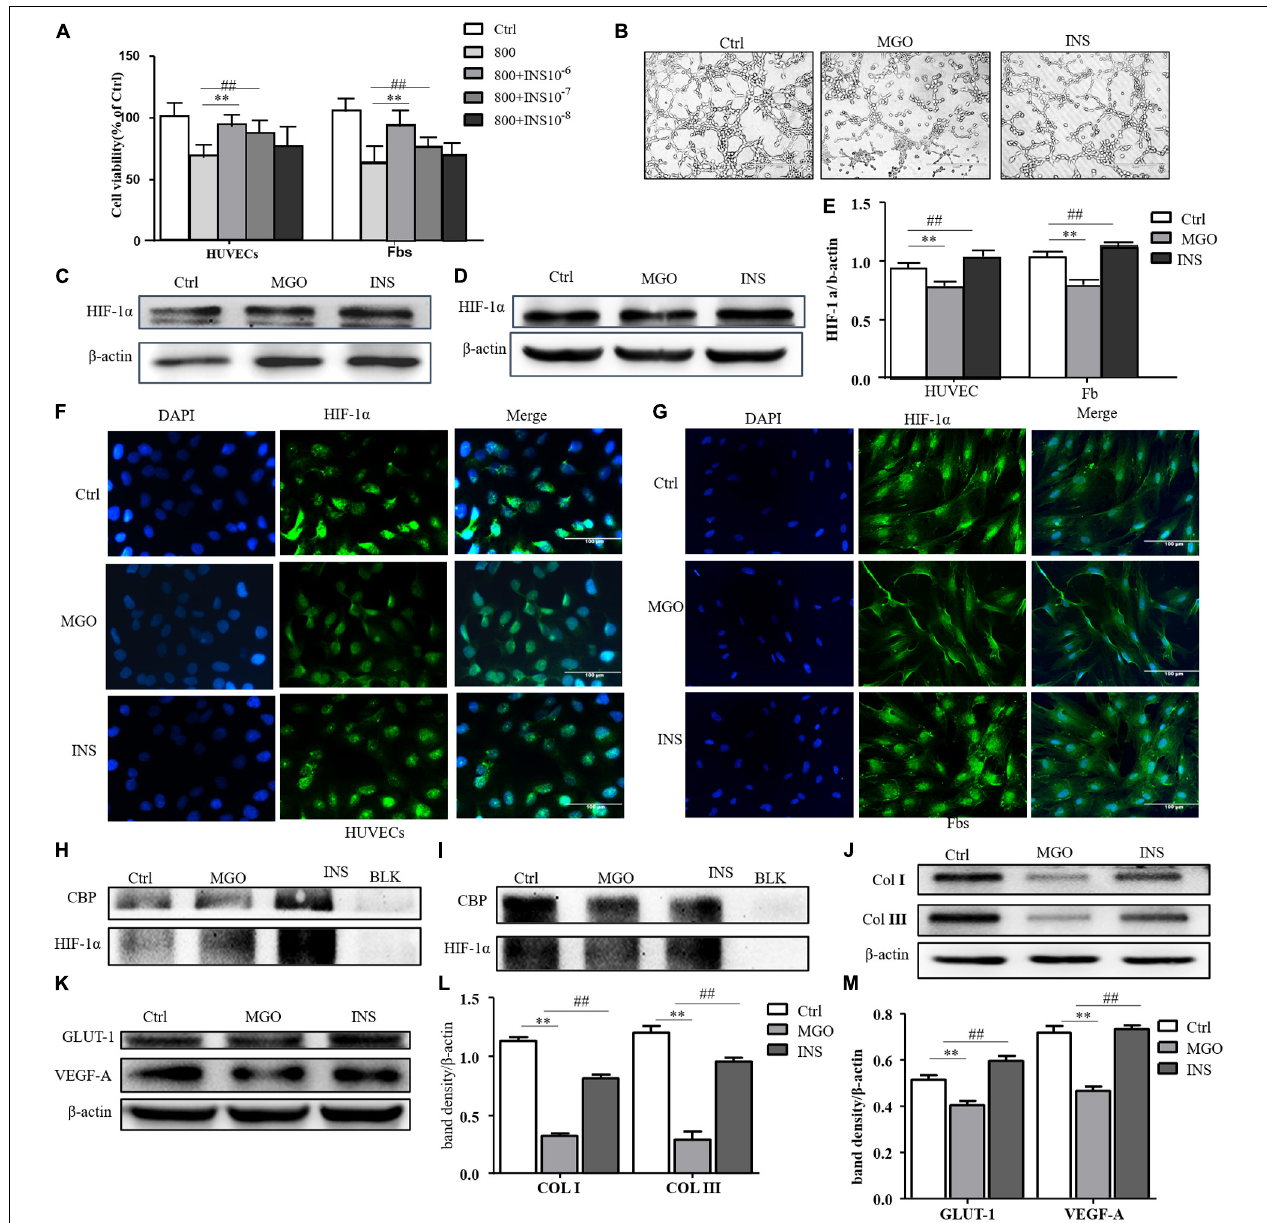
FIGURE 4 | Insulin relieved MGO-induced HIF-1 α impairment in wound healing cells. (A) Insulin promoted MGO-induced cell viability impairment in a concentration-dependent manner. HUVECs and fibroblasts were pretreated with 0 (control group) and 800 µ M MGO for 30 min. Thirty minutes after MGO treatment, 0, 10 - 6 , 10 - 7 , and 10 - 8 M insulin were added to the culture medium. After 24 h of incubation, cells were subjected to CCK-8 analysis. The viability of each group was compared with that of the control group and presented as the percentage of the control group. Data are shown as mean ± SD. **/## p < 0.01, n = 3. (B) Insulin promoted MGO-induced HUVEC angiogenesis impairment. HUVECs were set into three groups: control group (Ctrl) treated without MGO and insulin; MGO group (MGO) treated with 800 µ M MGO; insulin group (INS) treated with 800 µ M MGO and 10 - 6 M insulin. The treatment was described previously. Twelve hours later, the tube formation status in both groups was photographed. (C–E) Insulin alleviated MGO-induced HIF-1 α accumulation impairment of HUVECs and fibroblasts. HUVECs and fibroblasts were set as Ctrl, MGO, and INS groups and treated as described above. Twenty-four hours under the hypoxia state (1% oxygen concentration), cells were harvested, and HIF-1 α levels were analyzed. Photoshop was used in the quantification of immunoblots. Data are shown as mean ± SD. **/## p < 0.01, n = 3. *Means Ctrl vs. MGO; #means MGO vs. INS. (F,G) . Insulin promoted HIF-1 α translocation into HUVECs and fibroblasts. In Ctrl, MGO, and INS groups and after 24 h under the hypoxia state, cells were harvested and fixed with 4% paraformaldehyde. The cells were then subjected to immunofluorescence examination to analyze the HIF-1 α accumulation and translocation to the nucleus. (H,I) Insulin promoted translation complex formation of HIF-1 α and CBP in HUVECs and fibroblasts. Cell lysis of Ctrl, MGO, and INS was subjected to co-IP examination to analyze the HIF-1 α and CBP complex formation. (J–M) Insulin improved MGO-induced HIF-1 α pathway impairment in HUVECs and fibroblasts. Cell lysis of Ctrl, MGO, and INS was subjected to western blot to examine the expression of HIF-1 α target genes VEGF-A and GLUT-1 (HUVECs) and collagen I and collagen III (fibroblasts). Photoshop was used in the quantification of immunoblots. Data are shown as mean ± SD. **/## p < 0.01, n = 5. *Means Ctrl vs. MGO; #means MGO vs. INS.